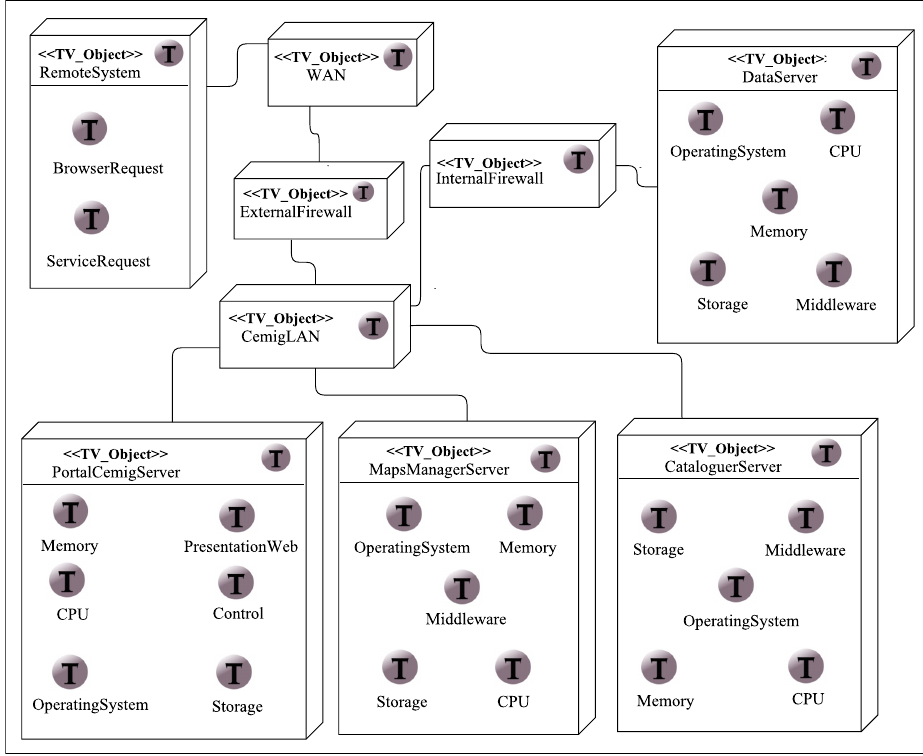
Figure 12. Technological objects of the Technology viewpoint for